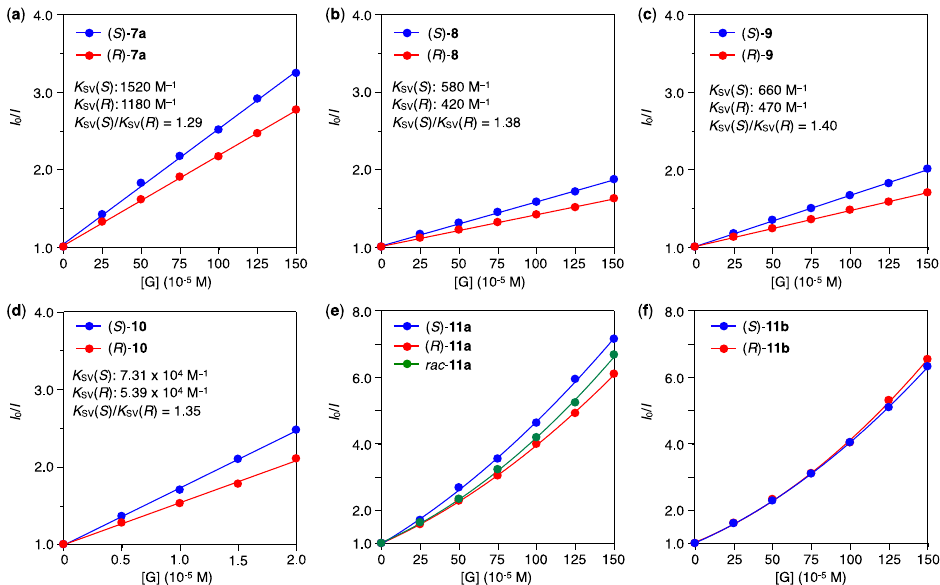
Figure 6. Stern–Volmer plots for the fluorescence quenching of Am- 1b ( λ ex = 450 nm) by the ( R )- (red) and ( S )- (blue) isomers of 7a ( a ); 8 ( b ); 9 ( c ); 10 ( d ); 11a ( e ) and 11b ( f ) in hexane/THF (90/10, v / v ) at room temperature. The result using rac - 11a as a quencher is also shown in ( e ). [Glucose unit] = 1.0 × 10 − 5 M.